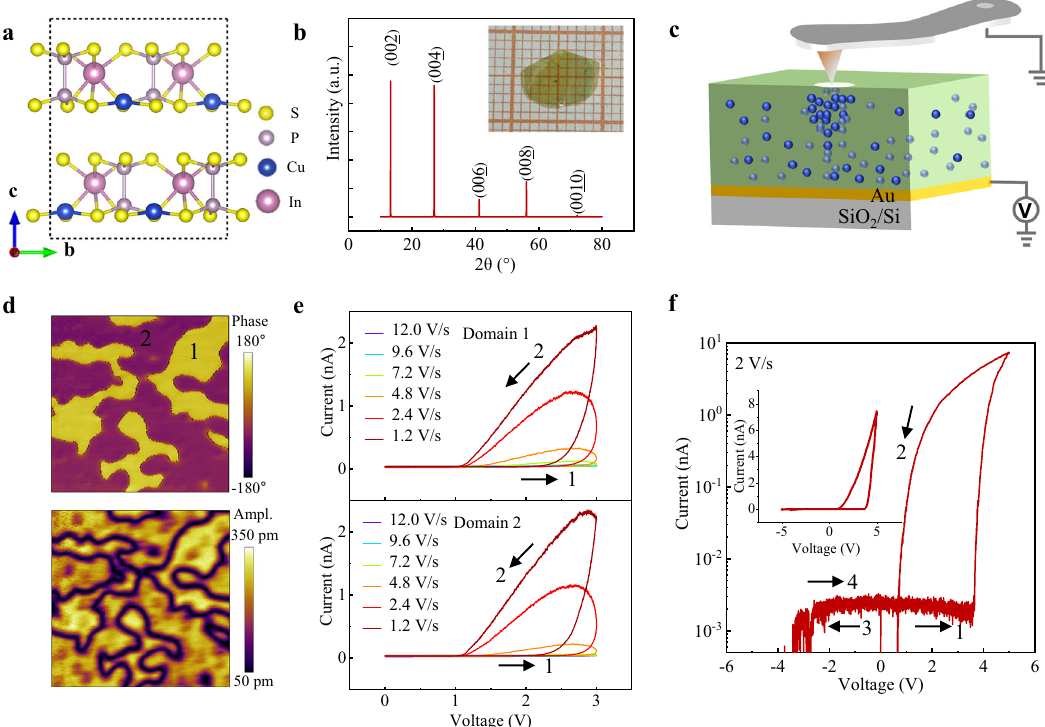
Fig. 1 Characterizations of CIPS single crystal and its electrical properties. a CuInP 2 S 6 crystal structure with a vdW gap between the layers; b The measured XRD pattern for as-grown CIPS single crystal with ab crystalline plane, the inset shows the fl exible CIPS crystal. c The schematic experimental setup for electrical measurement. Cu + ions are represented by the blue balls, which undergoes directional migration driven by the external electric fi eld. d Out of plane PFM phase and amplitude images of CIPS fl akes, respectively; e The consecutive sweeping speed-dependent I – V semi-cycles (0 V → + 3 V → 0 V) measured on two different domains with opposite direction in d. f A full cycle of I – V curve by sinusoidal voltage sweeping of 0 V → 5 V → -5 V → 0 V at a sweeping speed of 2 V/s. The thickness of CIPS is 120